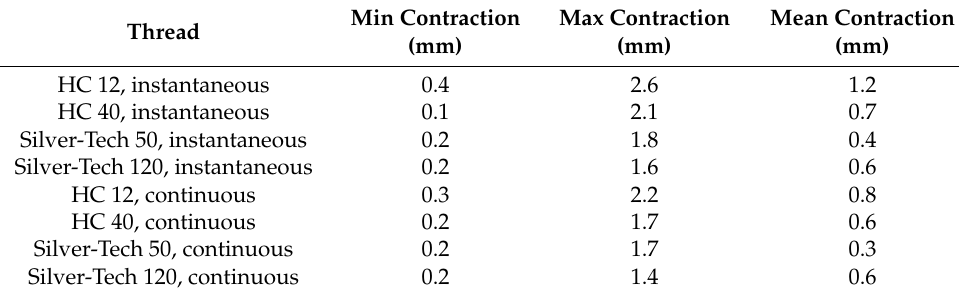
Table 4. Summary of the measured contraction of threads